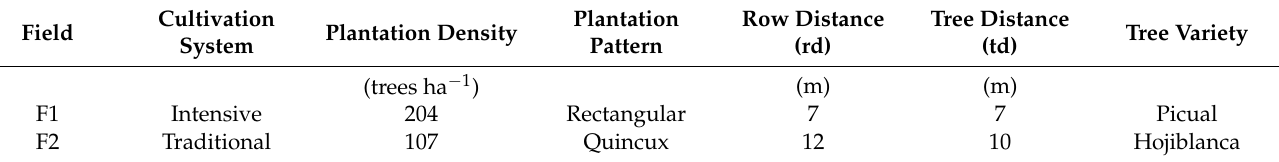
Table 1. Main characteristics of the two orchards selected for the field tests of the